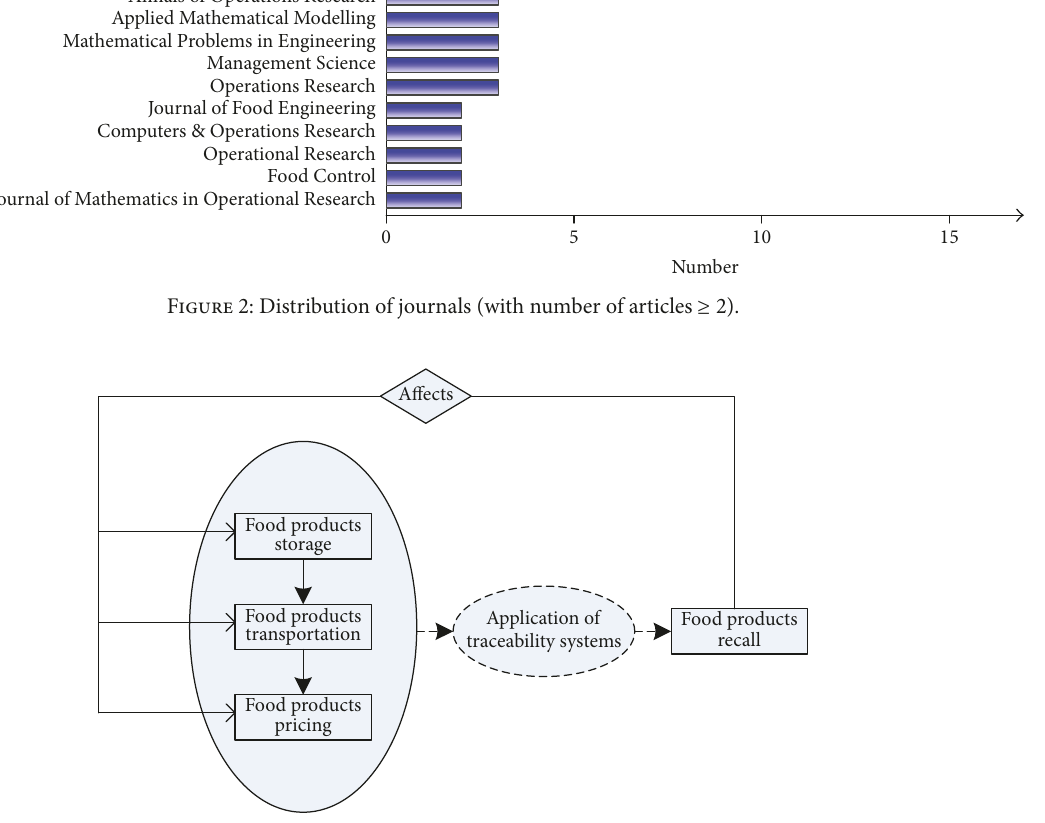
Figure 3: Conceptual